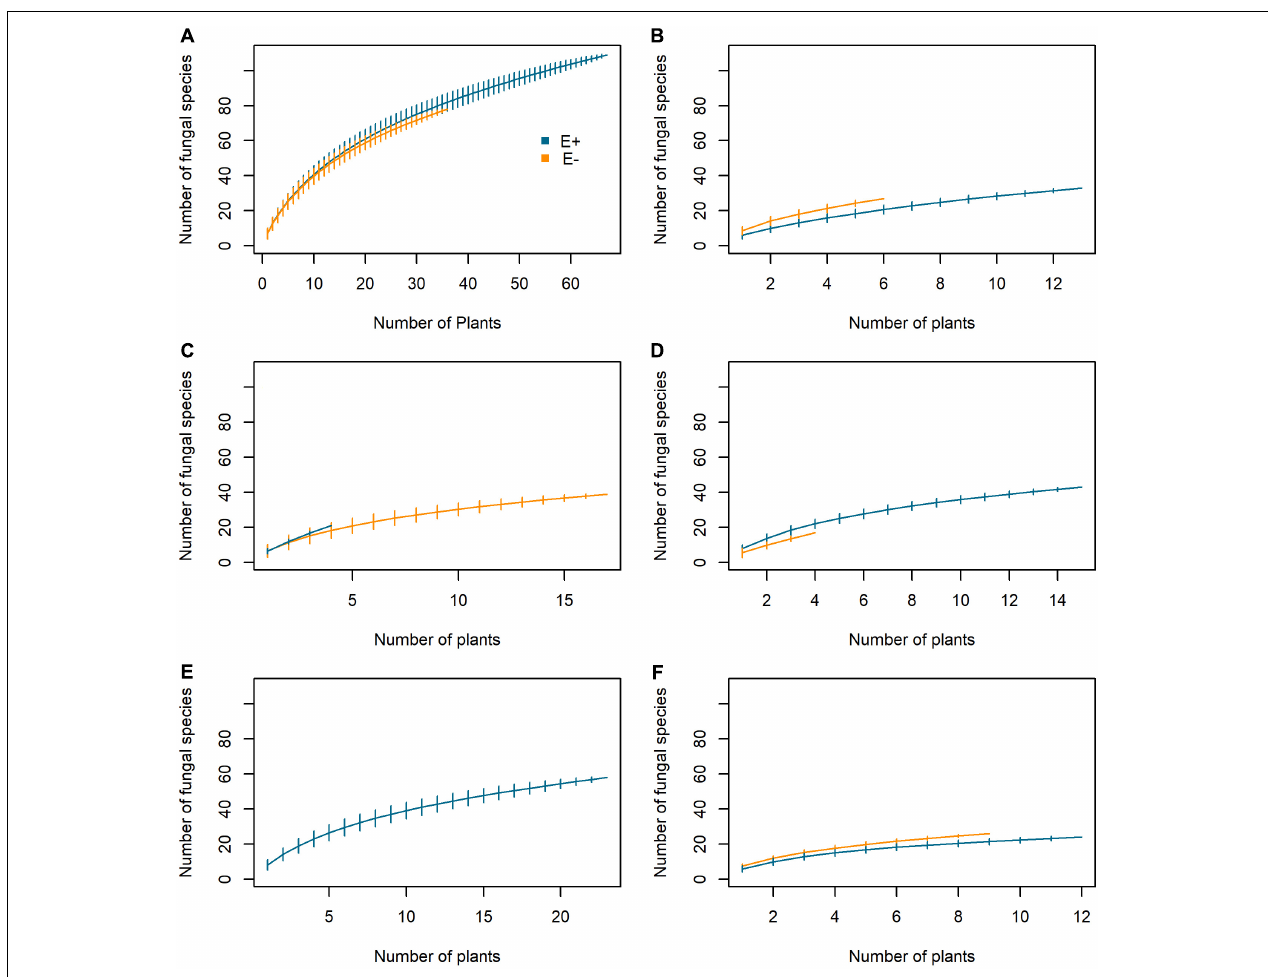
FIGURE 4 | Species accumulation curves of root mycobiota in Epichloë festucae infected (E+) and non-infected (E–) plants of Festuca rubra subsp. pruinosa from five marine cliff populations in northern Spain. (A) Whole plant set; (B) Cedeira; (C) Cabo de Peñas; (D) Estaca de Bares; (E) San Pedro de la Rivera; (F) Torre de